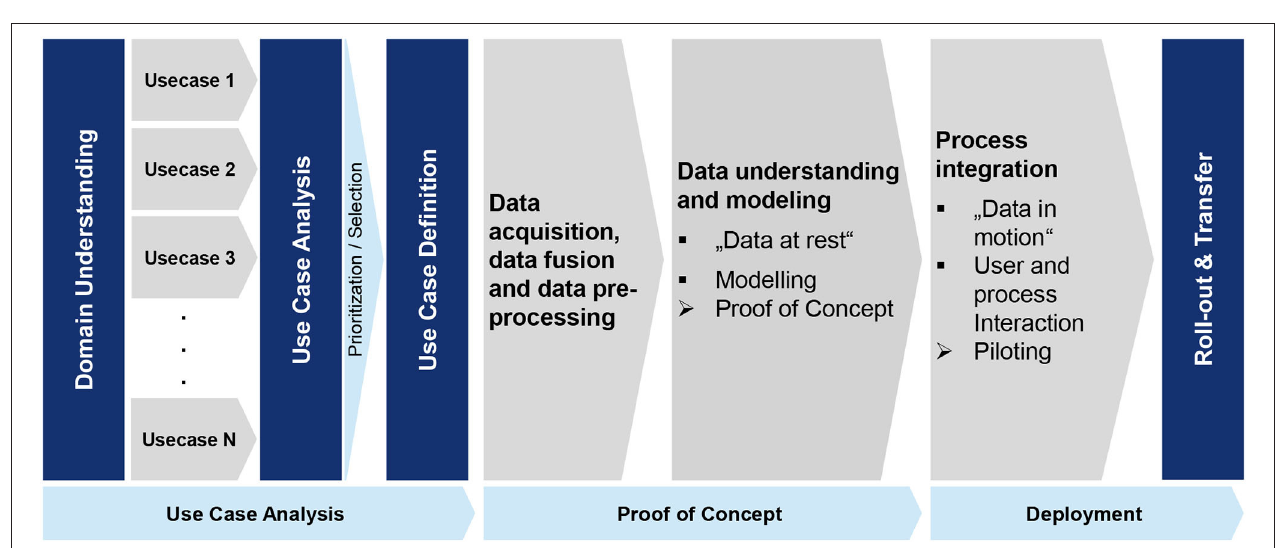
FIGURE 1 | Overall process for the implementation of predictive analytics.